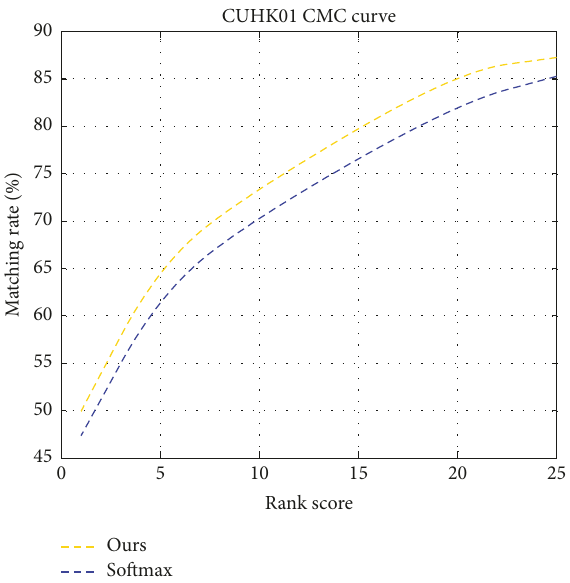
Figure 7: Performance comparison with softmax layer using CMC curves on CUHK01